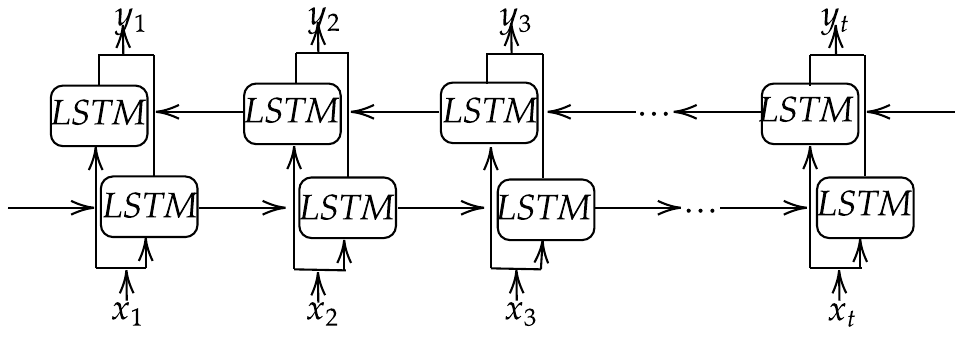
Figure 5. One layer BLSTM